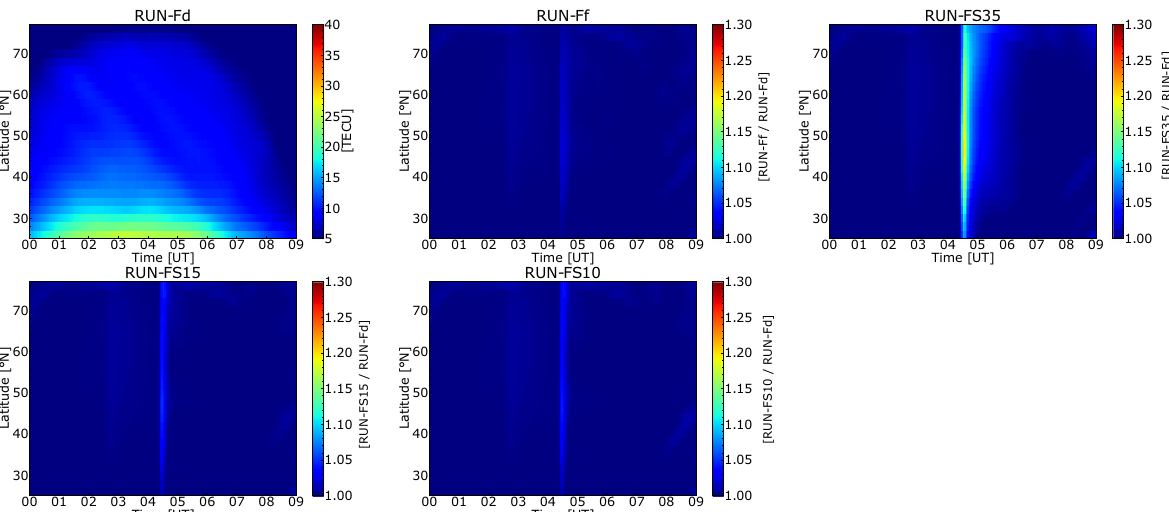
Fig. 4 Ratio of TEC distribution calculated by GAIA. The ratio of TEC distribution calculated by RUN-Fd for RUN-Ff, RUN-FS35, RUN-FS15, and RUN-FS10 at 130°E around noon local time at the time of the flare shown in Fig. 3 for the X1.1-class flare on November 8,